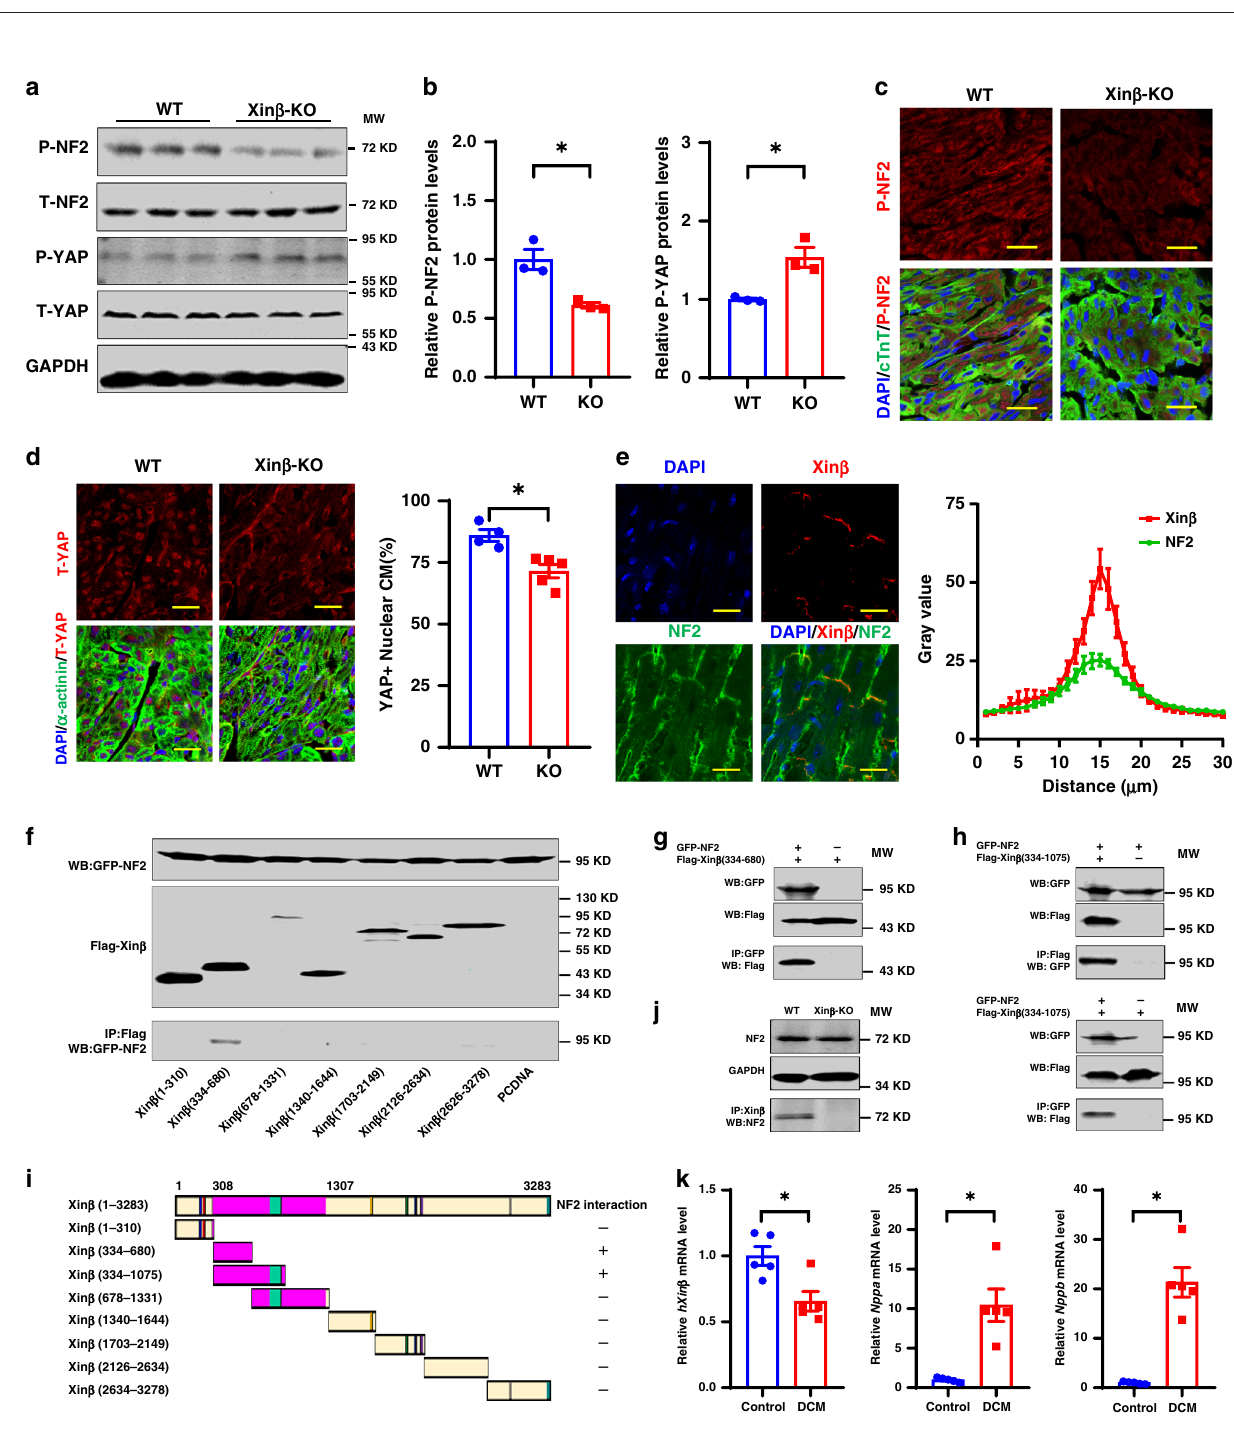
Fig. 3 Heart-speci fi c YAP S127A overexpression rescues cardiac defects in Xin β KO mice. a Diagram of the work fl ow. b Survival curve of WT and Xin β KO mice injected with AAV- aYAP ( YAP S127A ) or control AAV- GFP . c Gross morphology of P7.5 WT and Xin β KO mice injected with AAV- aYAP or control AAV- GFP . Scale bars = 1 cm. d Heart gross morphology and, e histology, of P7.5 WT and Xin β KO mice injected with AAV- aYAP or control AAV- GFP . Scale bars = 2 mm ( d ) and 1 mm ( e, f ). Principal component analysis of all expressed genes in P7.5 WT and Xin β KO mice injected with AAV- aYAP or control AAV- GFP . g Hierarchical clustering heatmap of differentially expressed genes. h Gene set enrichment analysis (GSEA) of differentially regulated pathways P7.5 WT and Xin β KO mice injected with AAV- YAP or control AAV- GFP . i Enrichment plot of rescued YAP-conserved signatures in Xin β KO hearts injected with AAV- aYAP . j qRT-PCR of cell-cycle-related genes in the hearts of WT and Xin β KO mice injected with AAV- aYAP or control AAV- GFP . N = 6 or 7 biologically independent samples, * P < 0.05. k pH3 staining of hearts from P7.5 Xin β KO and control mice injected with AAV- aYAP or control AAV- GFP . DAPI marks nuclei, α -actinin labels cardiomyocytes. Quanti fi cation in right panel. Scale bars = 40 µ m. N = 5 or 6 biologically independent samples, * P <